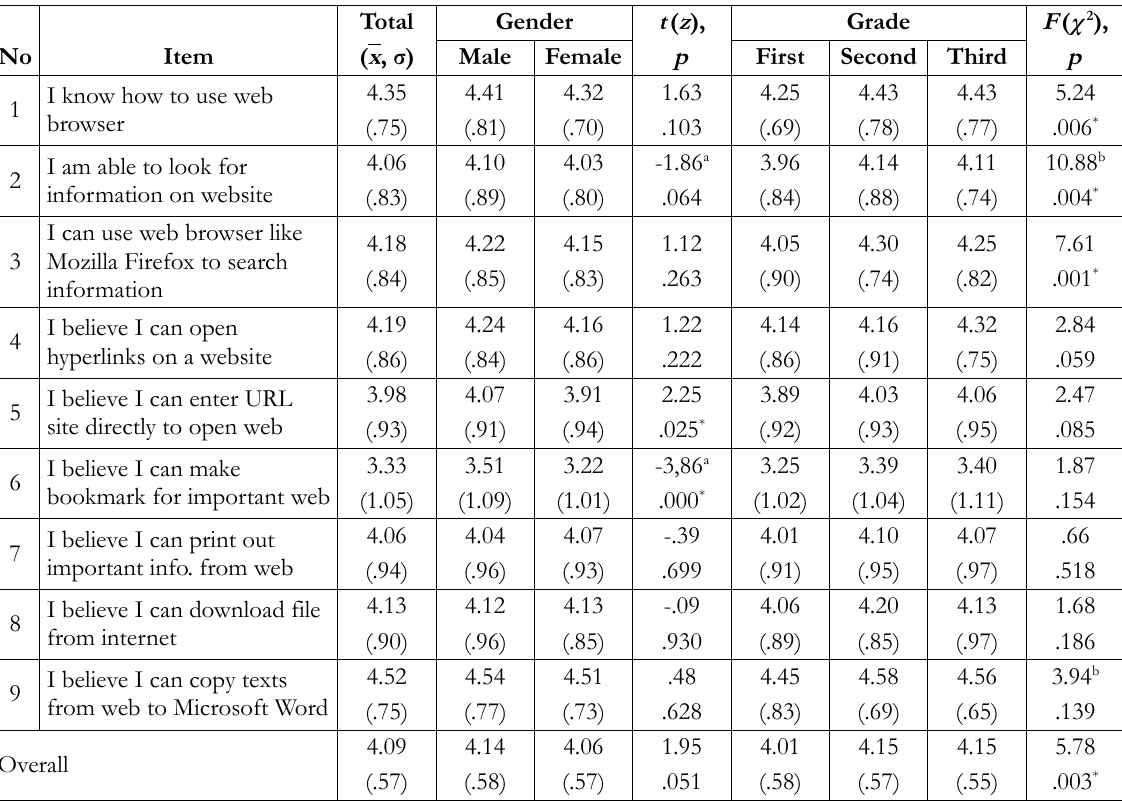
Table 6. Students’ internet self-efficacy